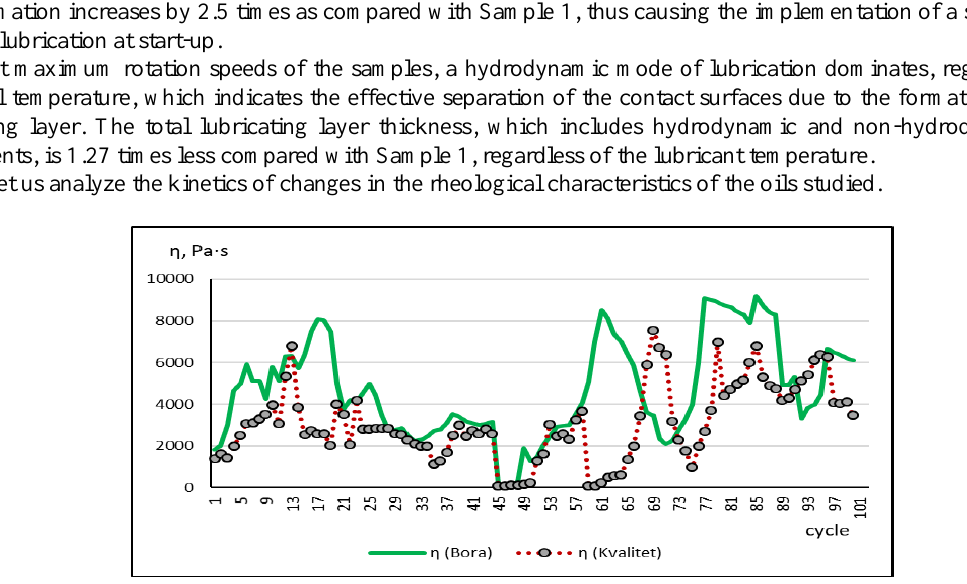
Fig. 5. The kinetics of change in the effective viscosity (η) of oils in the